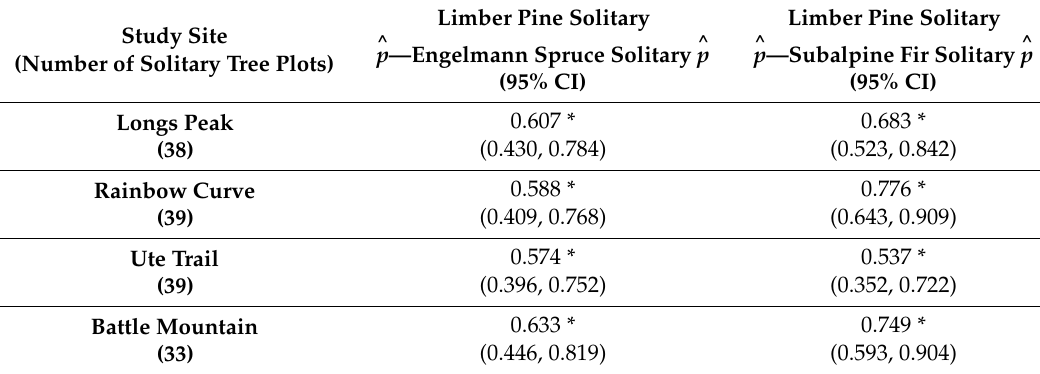
Figure 6. Proportion of multi-tree islands that included subalpine fir ( A. lasiocarpa —ABLA), Engelmann spruce ( P. engelmannii —PIEN), and limber pine ( P. flexilis —PIFL) at the Battle Mountain (BM), Longs Peak (LP), Rainbow Curve (RC), and Ute Trail (UT) study sites. The number of multi-tree islands at each site is in parentheses. Proportions do not add to one because a multi-tree island may contain more than one species. Where confidence intervals do not overlap, di ff erences are significant at the α = 0.05 threshold.